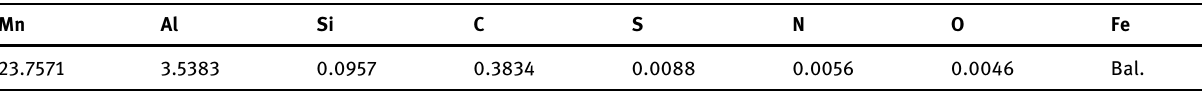
Table 1: Chemical composition of TWIP steel ( wt% )